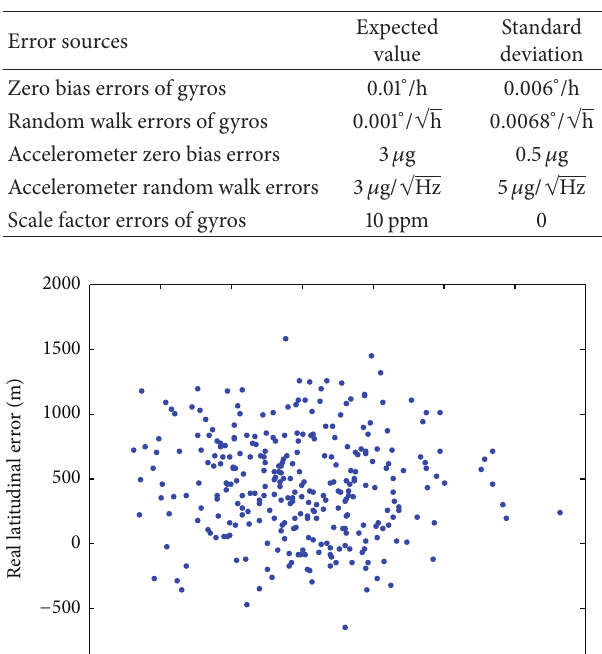
Table 1: The expected value and standard deviation of error sources.